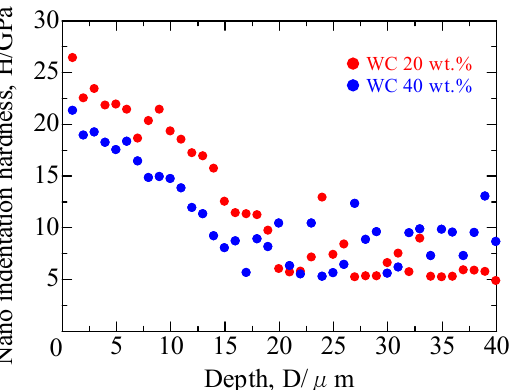
Figure 7. Hardness depth profiles of the S-phase layers at the nitriding temperature of 450 °C with various WC compositions.